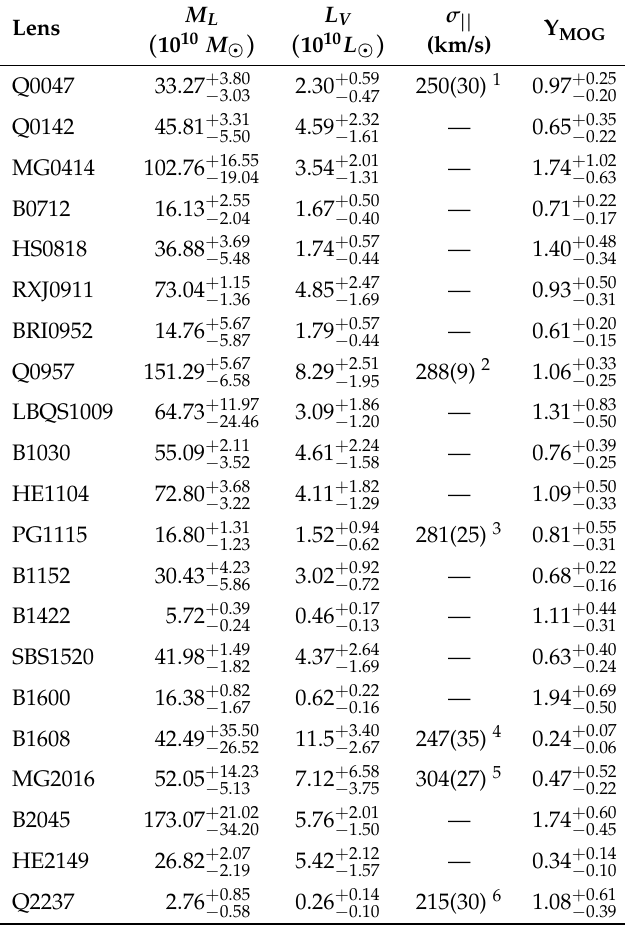
Table 1. Data for 21 strong lensing objects. Lensing mass and stellar luminosity estimates are from [17]. The value of the baryonic mass-to-light ratio under MOG, Υ MOG , is predicted, as described in the text.